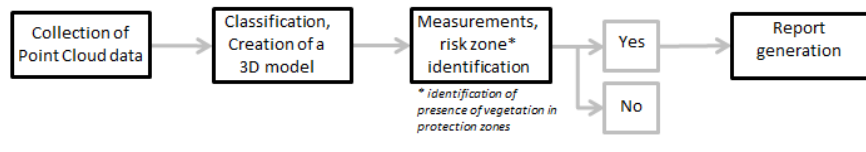
Figure 24. Vegetation control workflow.